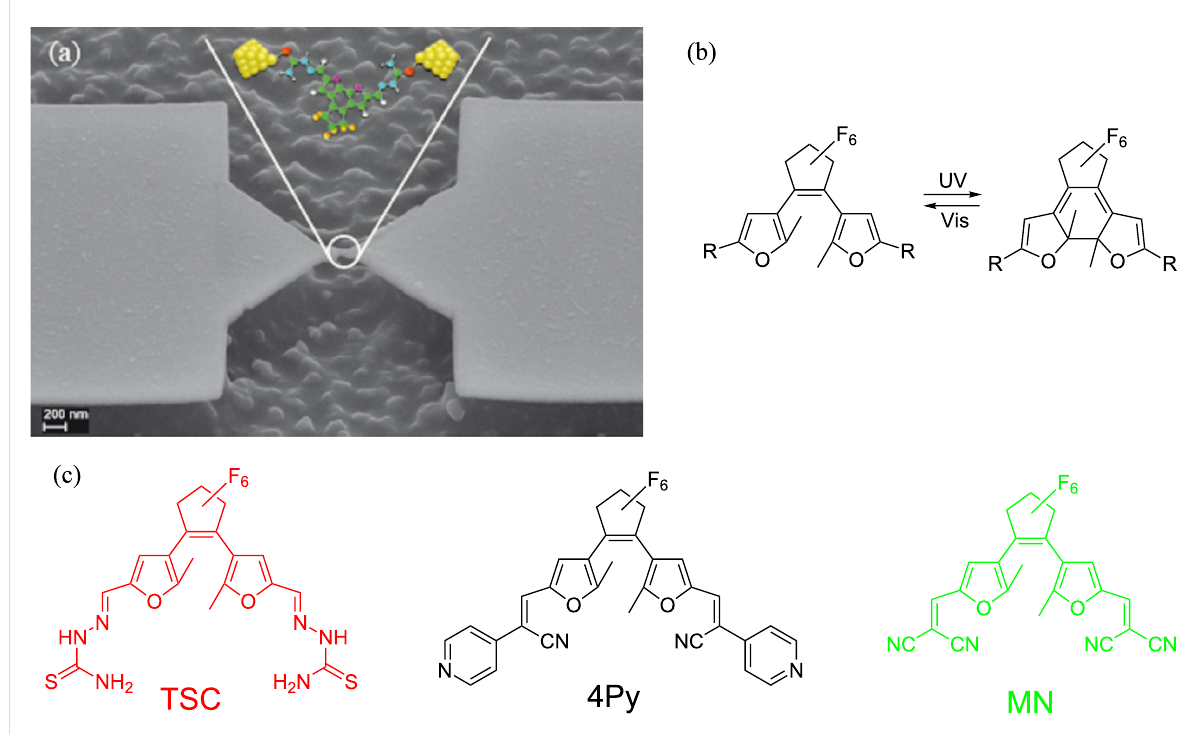
Figure 1: (a) Scanning electron micrograph of the MCBJ device with an illustration of a Au–4Py–Au junction. (b) Sketches of open (left) and closed (right) forms of photochromic molecules (difurylethene); R indicates the extended side-arms and end-groups. (c) Structures of three different mole- cules, 4Py (black), TSC (red), MN (green) investigated in this study.